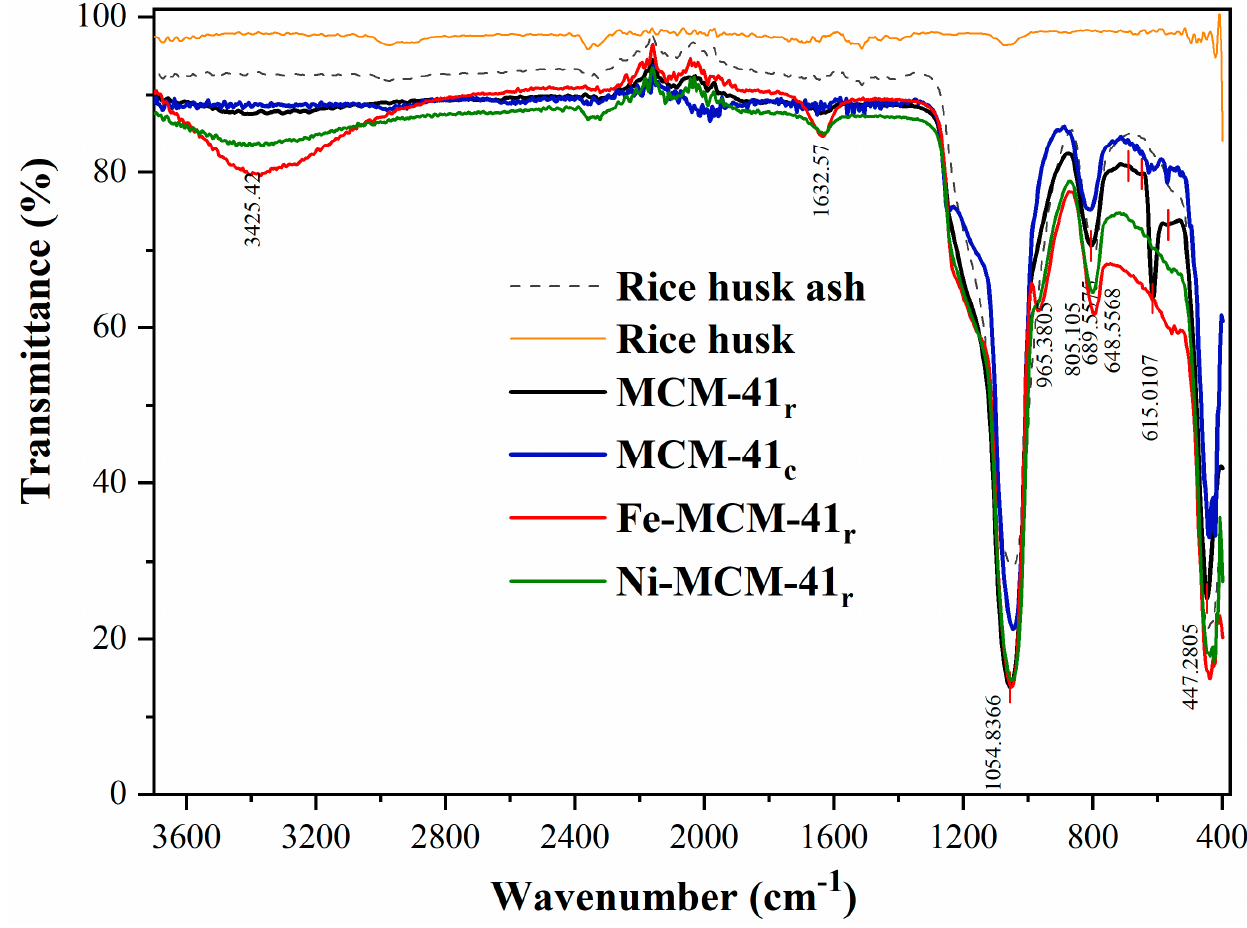
r ( a ) and Ni-MCM-41 r ( b ).